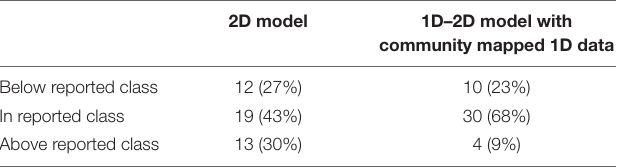
TABLE 6 | Summary of model development results. 2D